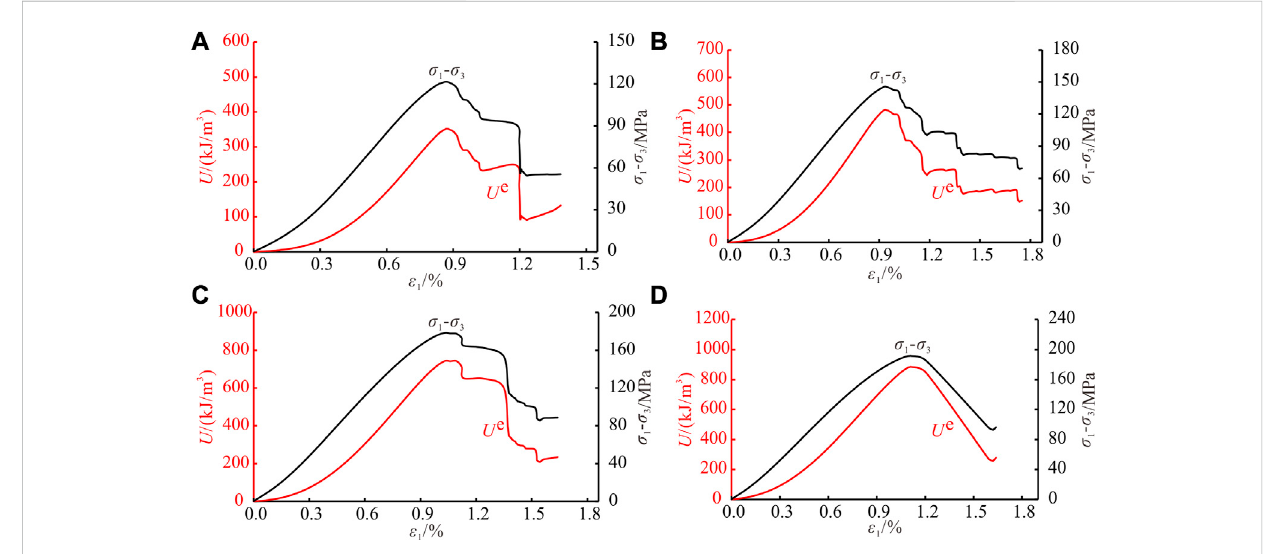
FIGURE 7 Evolution of elastic strain energy under CTC. (A) σ 3 = 5 MPa. (B) σ 3 = 10 MPa. (C) σ 3 = 15 MPa. (D) σ 3 = 20